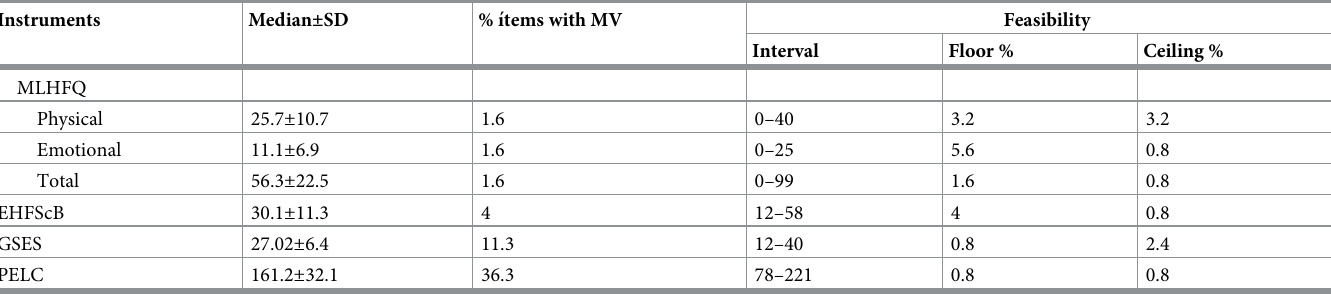
Table 2. Scores and feasibility coefficients for the MLHFQ, EHFScB, GSES and PELC instruments (n =